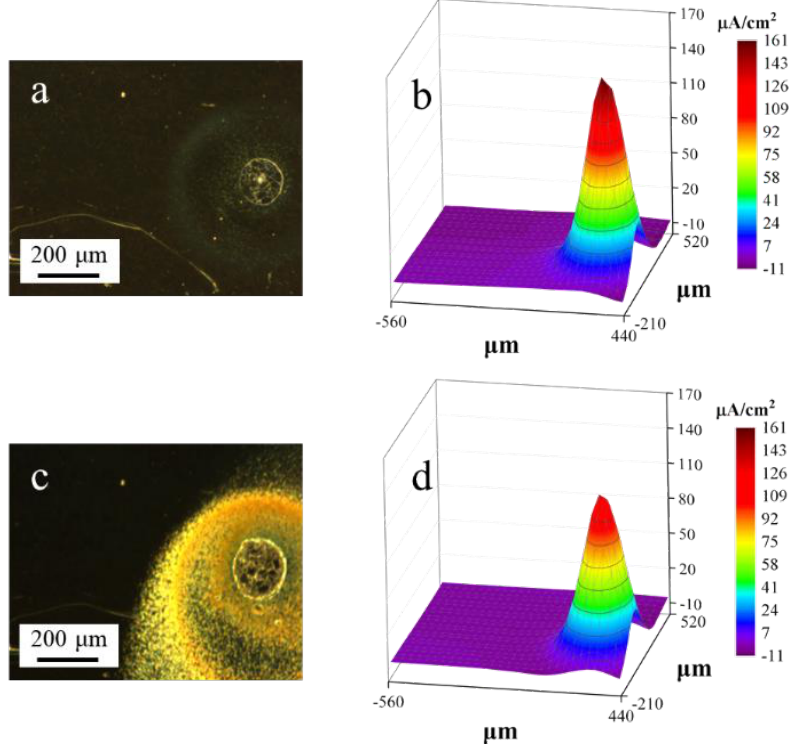
Figure 5. Optical-microscope images ( left ) and ionic current maps ( right ) of the experimental steel during immersion in the solution for: ( a , b ) 5 min; and ( c , d ) 30 min. Test area size: ~1 mm 2 .